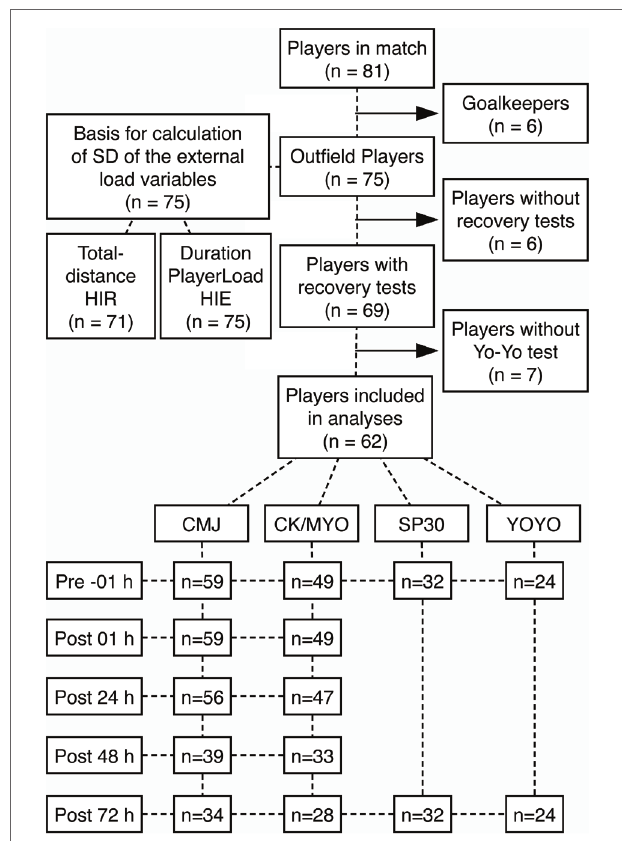
FIGURE 1 | Flow chart showing number of participants included in (1) the analyses of the different recovery markers on each time-point and (2) the calculation of SD which were used for the rescaling of the external load